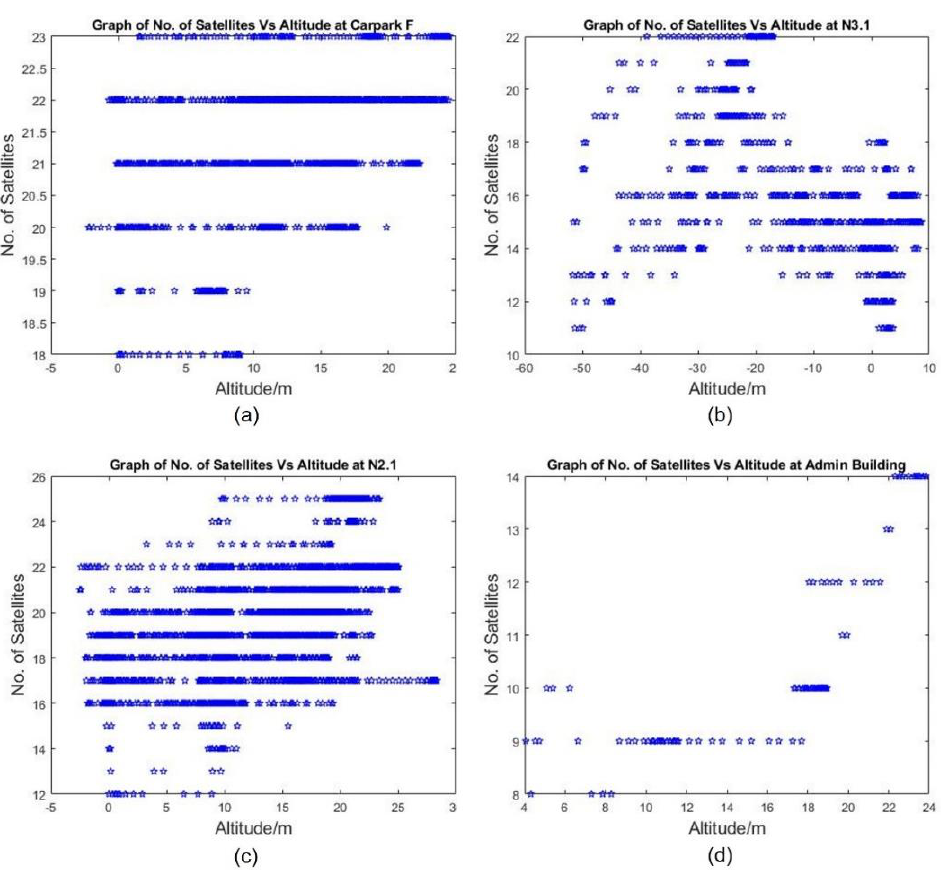
Figure 9. Graphs of No. of Satellites vs. Altitude at the 4 Locations: ( a ) Car Park F, ( b ) N3.1, ( c ) N2.1 and ( d ) Admin Building.